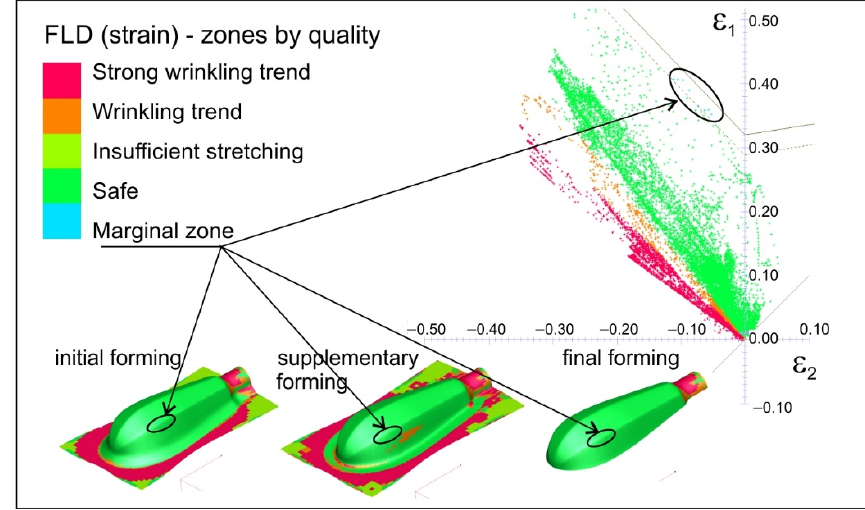
10 of 15 Figure 10. Thickness distribution in drawn part wall after: ( a ) initial forming; ( b ) supplementary forming; ( c ) final forming performed with lubricant. Greater thinning of the drawn part walls is observed in the case of forming in dry conditions. The greatest thinning occurs on the edges of the handle, in the area with the small fillet radius. The application of lubricant ( μ = 0.1) causes a more uniform thickness distribution—the wall thinning is smaller. During forming without lubrication, significant material deformation along the edge of the drawn part occurs, which results in excessive thinning of the sheet and can lead to